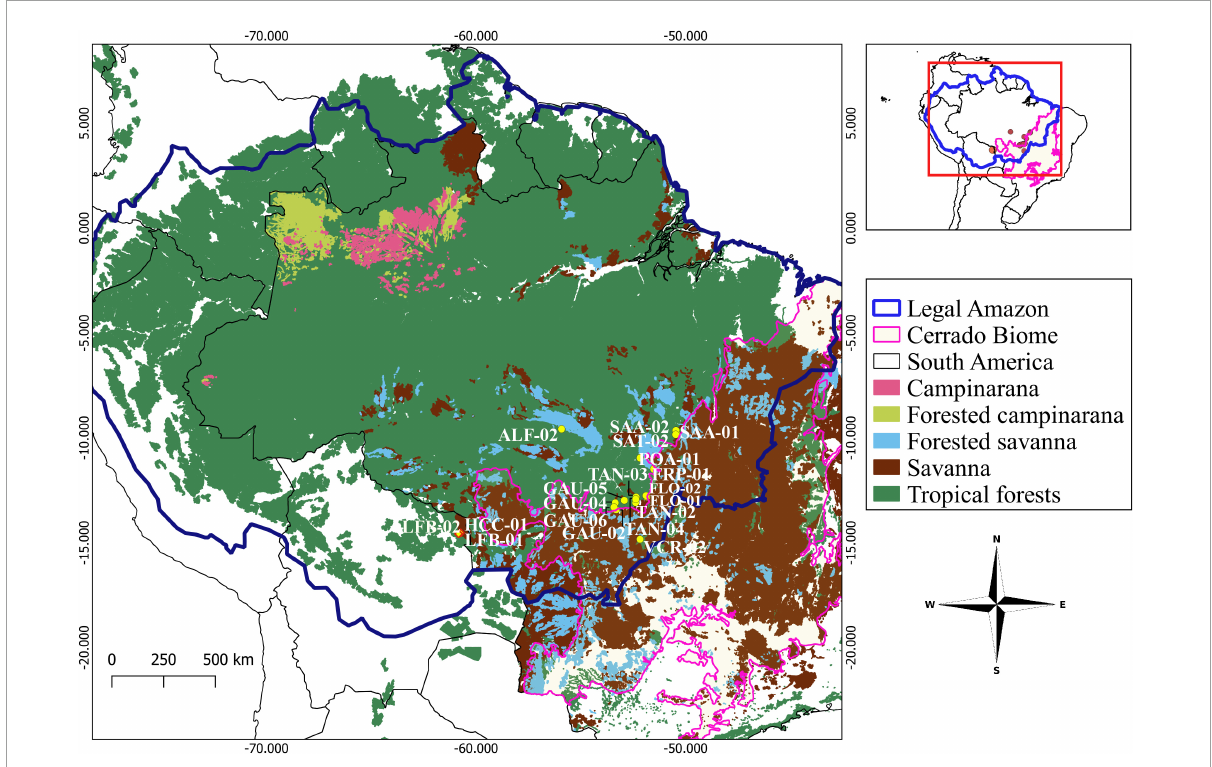
FIGURE1 The location of the permanent forest plots along the Amazon-Cerrado transition. The blue line represents the limit of the Legal Amazon, the black line country boundaries, and the pink line the limit of the Cerrado biome.